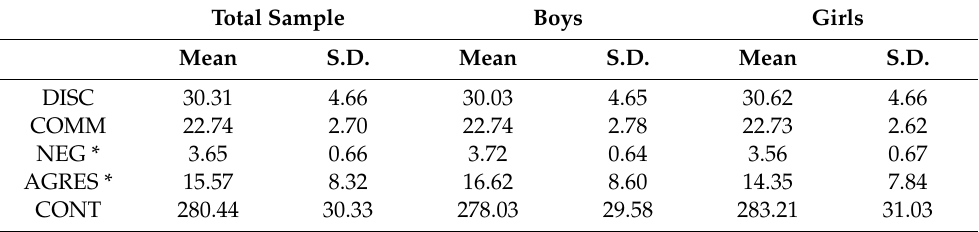
Table 1. Basic descriptive statistics in the total sample and by gender for the 1–3 year-old group. Total Sample